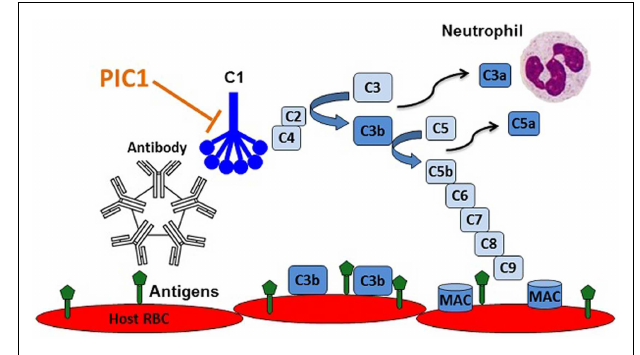
FIGURE 5 | Recognition of RBC antigens on recipient cells by host derived natural antibodies initiating classical complement via C1 leading to opsonization of host cells with C3b, anaphylatoxin C5a recruitment and activation of neutrophils, and cell lysis by membrane attack complex (MAC) pores . PIC1 blocks C1 activation at the first step of the amplification